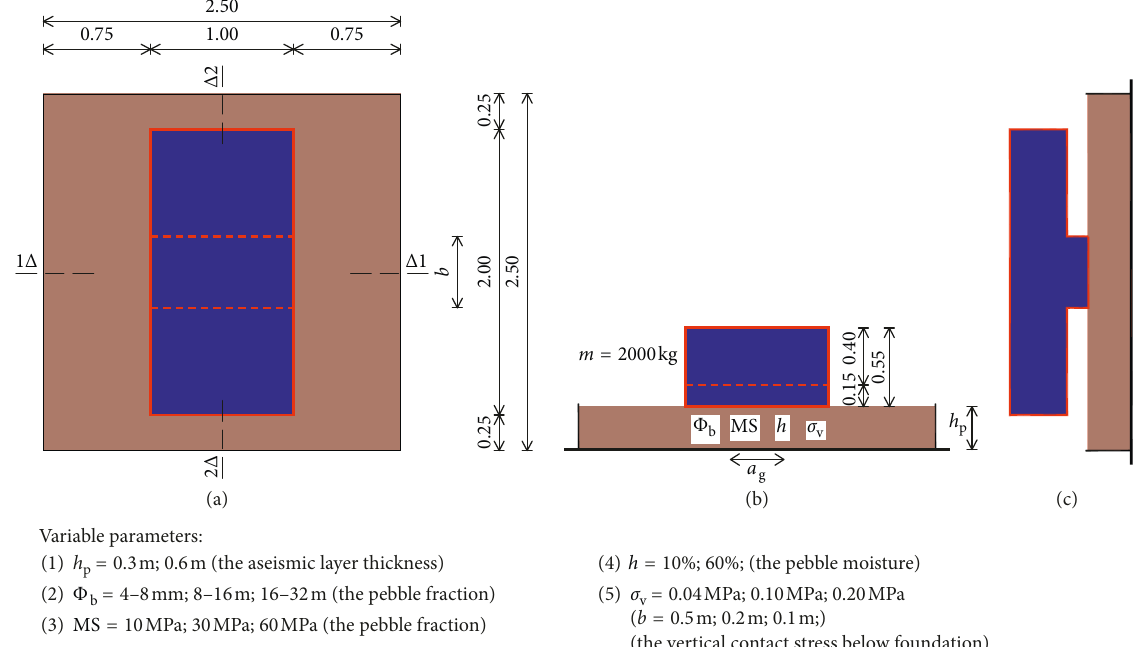
Figure 1: Adopted model of rigid building and aseismic layer. (a) Layout of model. (b) Section 1-1. (c) Section 2-2.